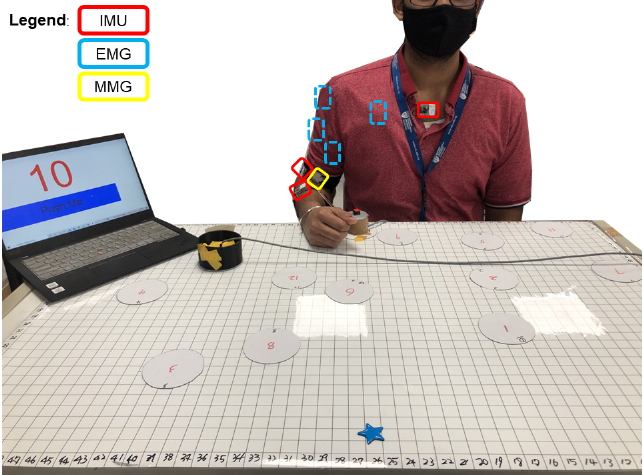
Figure 2. Experimental setup: The subject sat in front of the experimental table. Then, he moved the cup according to the number of the positions indicated on the screen of a